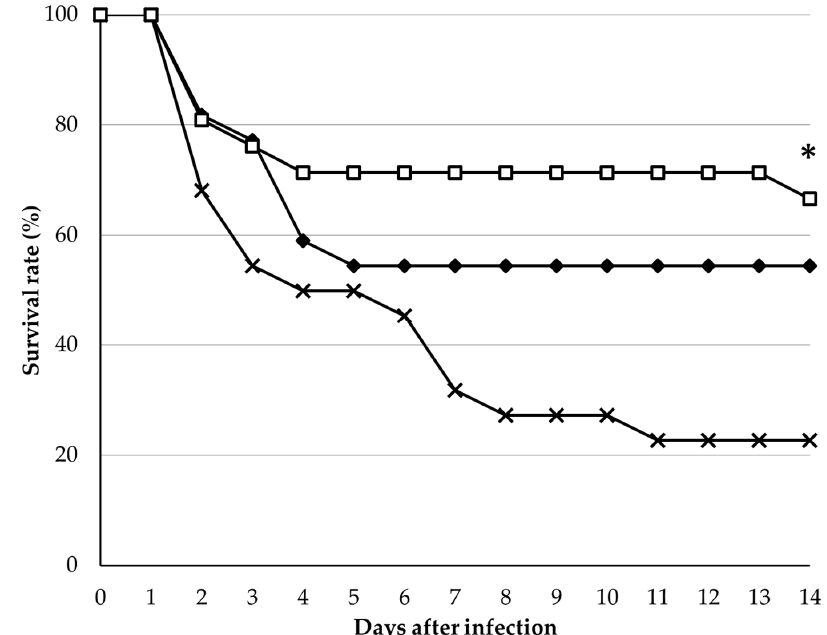
Figure 2. Survival rates of red seabream after infection with Edwardsiella tarda . Control diet group (X mark), 5% MW diet group (filled diamond), and 10% MW diet group (open square). The asterisk * indicates statistically significant differences compared with the control group using a log rank test with a Bonferroni correction ( p < 0.05).